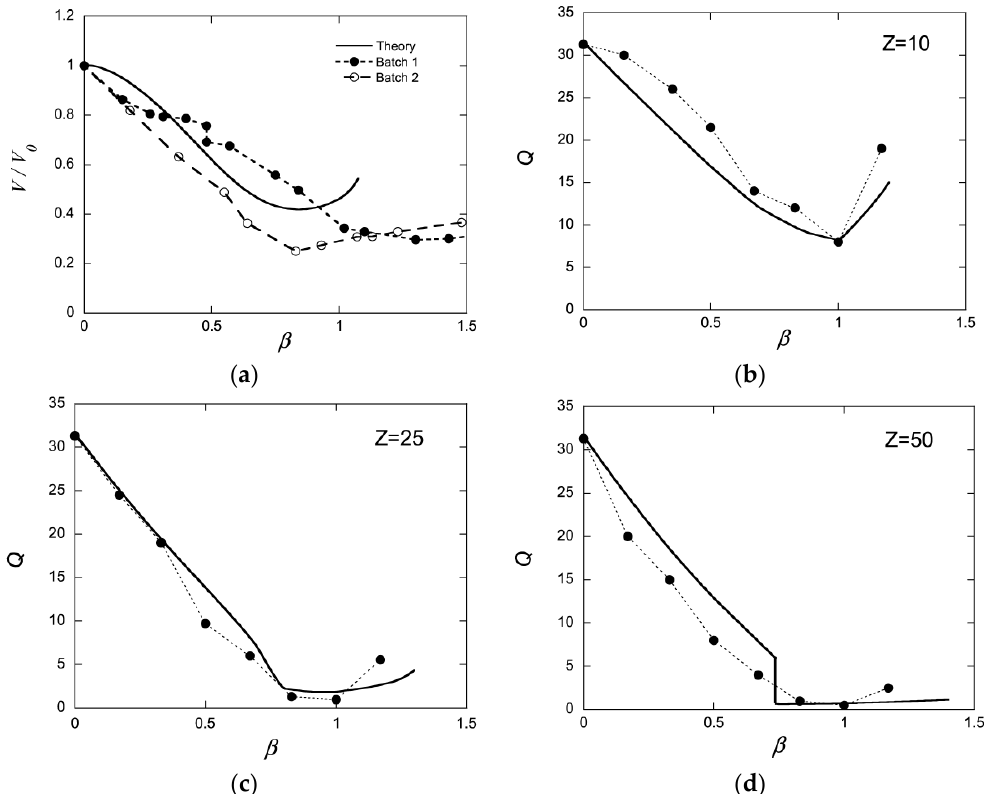
Figure 1. ( a ) Swelling isotherms for a polyacrylate (PA)-microgel in a solution of cytochrome c determined by Jidheden and Hansson (J&H). The microgel volume relative that in protein-free solutions ( V / V 0 ) is plotted vs. the protein/network charge ratio ( 𝛽 ) in the gel; ( b )–( d ) swelling isotherms for a model system of charged network + spherical macroions of charge as indicated. Symbols are from Monte Carlo simulations by Edgecombe and Linse [59]. Solid curves in both figures are the predictions by the gel model used by J&H [60]. Reprinted with permission. Copyright 2016 American Chemical Society.